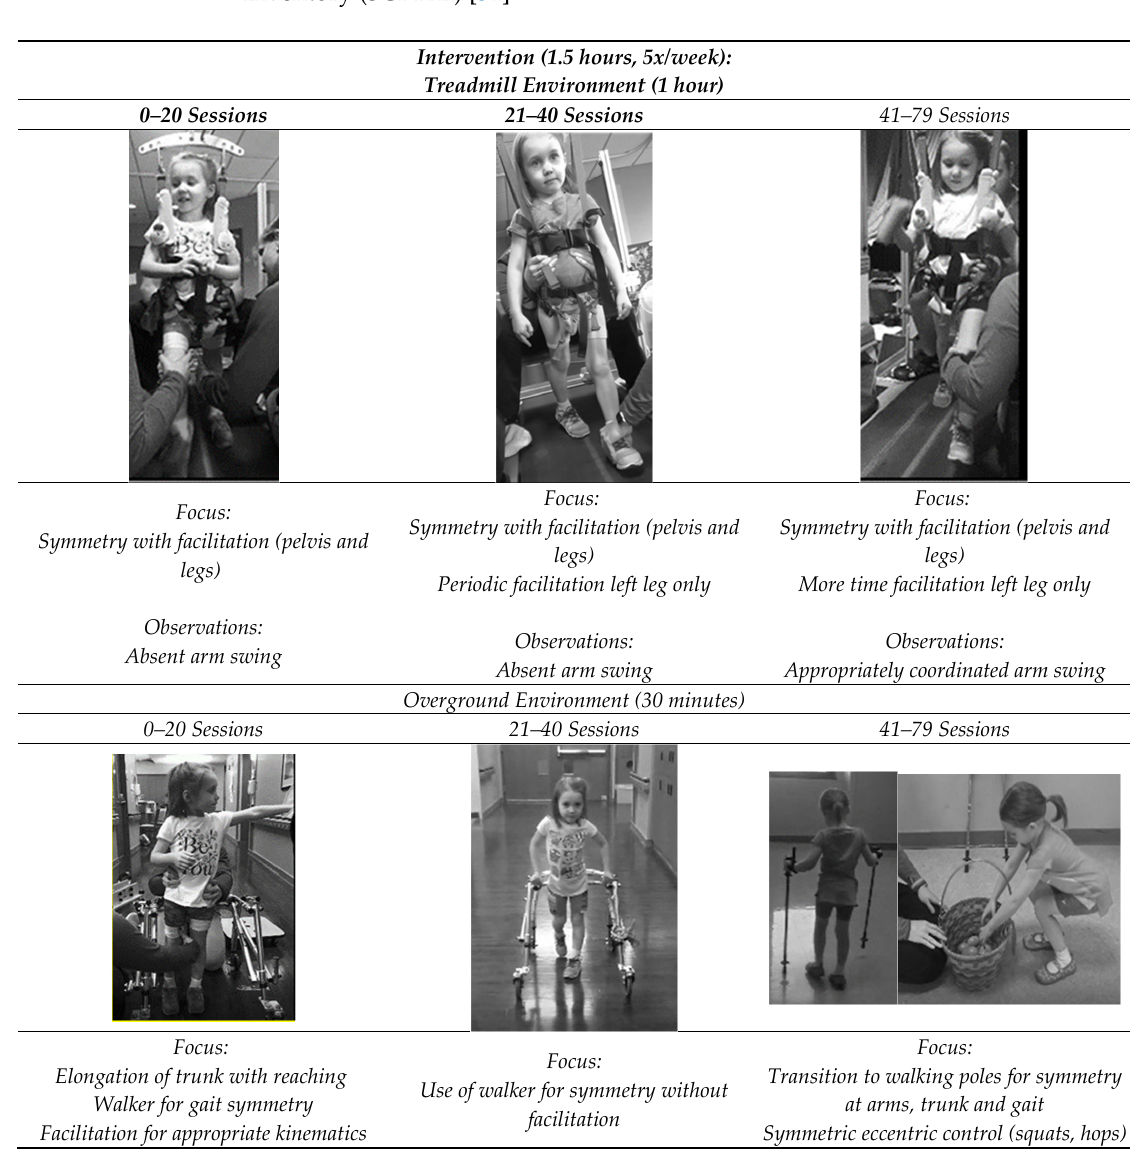
Figure 3. Progression of Activity ‐ Based Restorative Therapy (ABRT) intervention. Focus changed across 3 intermittent periods between re ‐ assessments at 20, 40 and 79 sessions. Trends towards symmetry were noted in arm swing, stepping pattern and trunk.